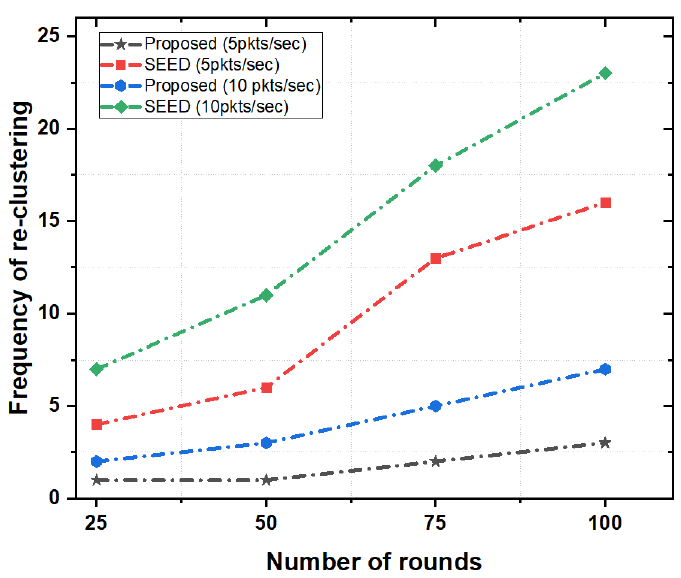
Figure 6. Frequency of re-clustering as a function of the number of